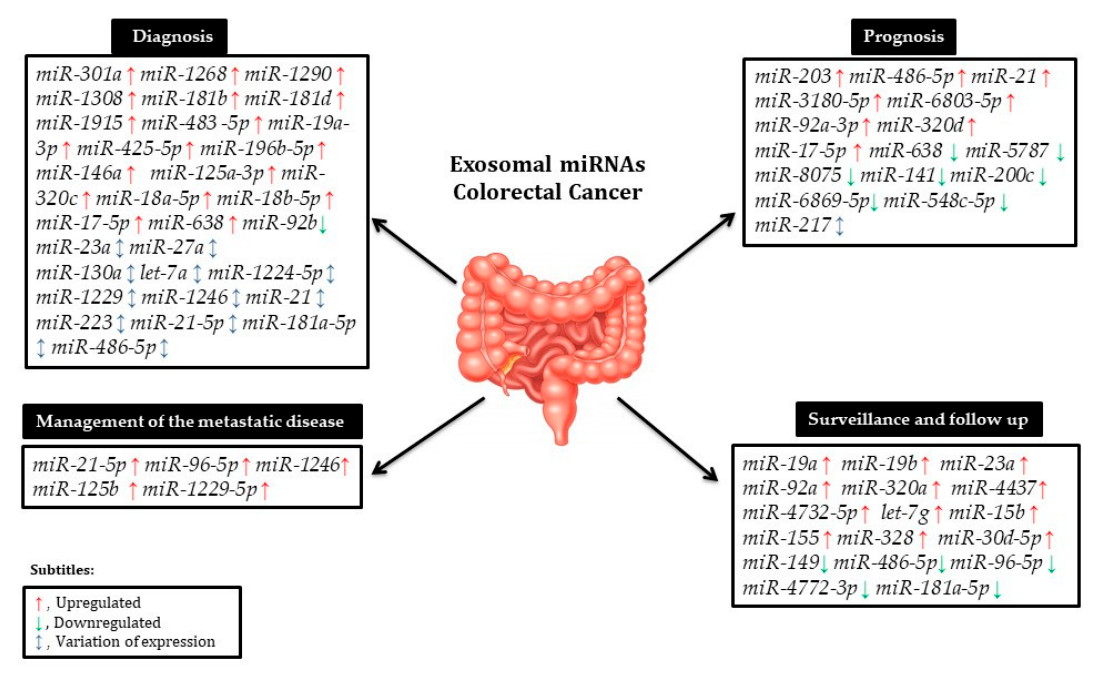
Figure 1. Circulating exosomal microRNAs (miRNAs) and their role in the diagnosis, prognosis, surveillance, and monitoring of colorectal cancer (CRC) metastatic disease.